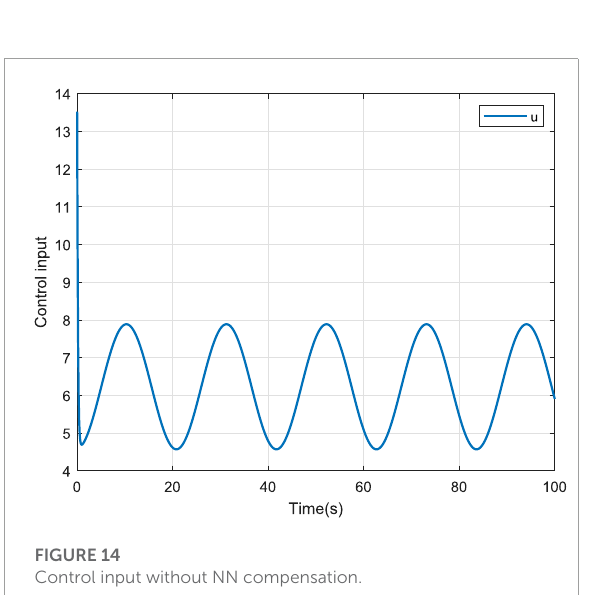
FIGURE 13 Tracking error with NN compensation.